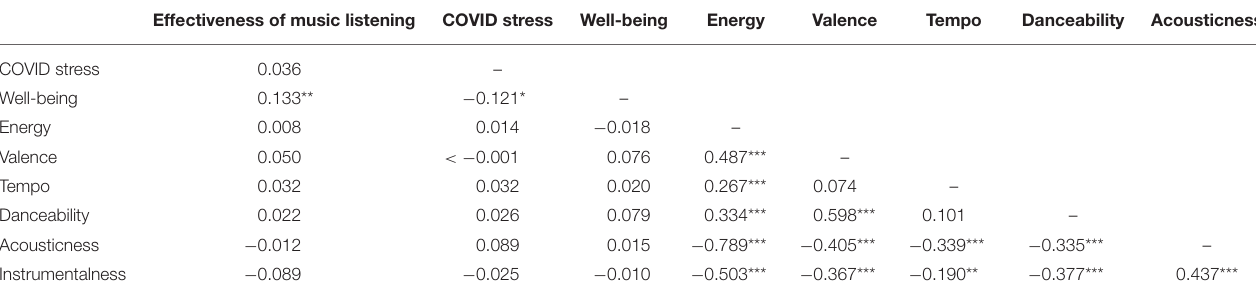
TABLE 1 | Pearson’s correlations for musical features and